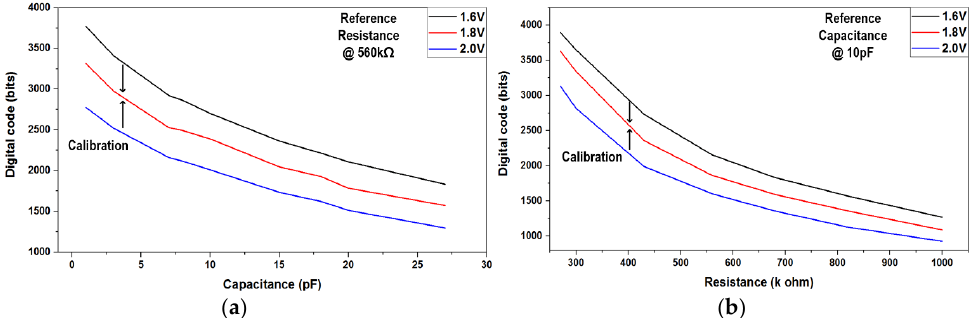
Figure 11. Measured characteristics of X-to-digital converters (XDC)-based readout circuit: ( a ) capacitive and ( b ) resistive.